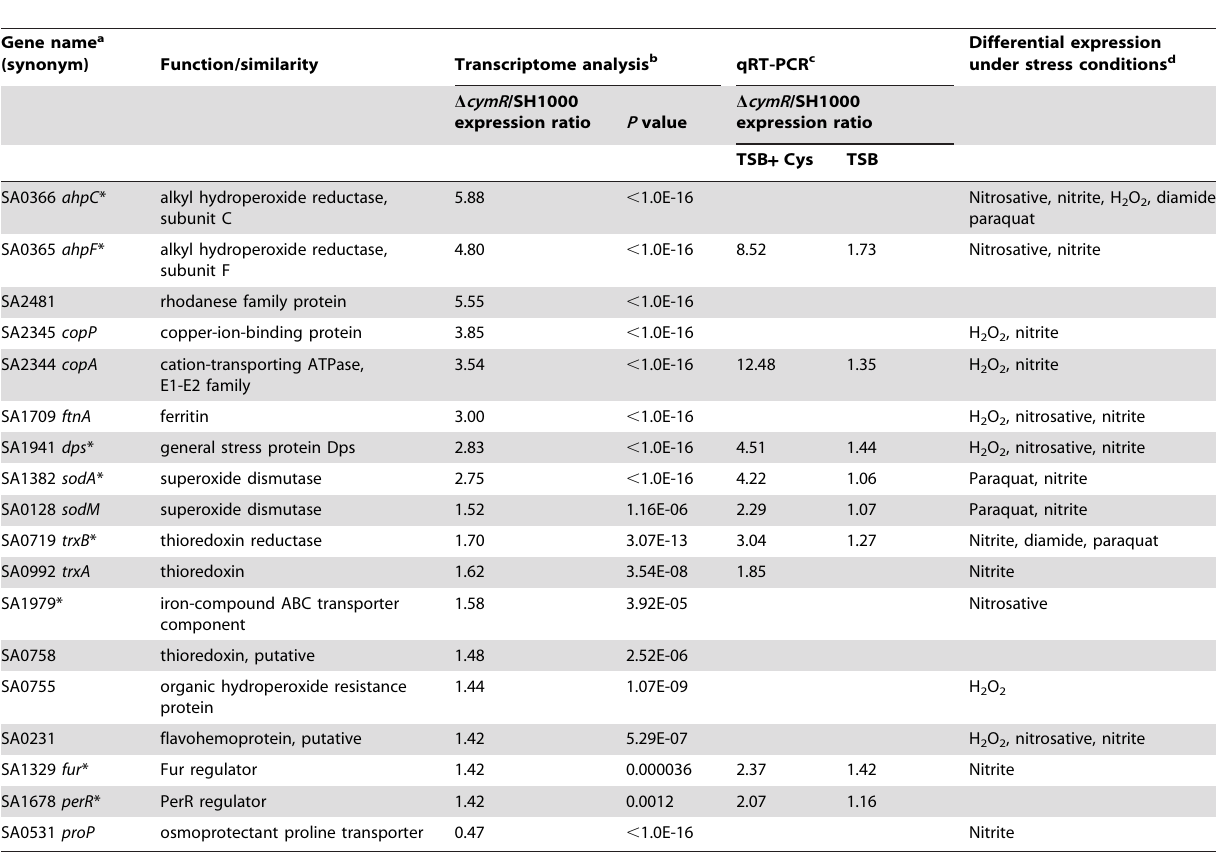
Table 1. Stress response associated genes differentially expressed in the S. aureus D cymR mutant strain compared to SH1000. Gene name a